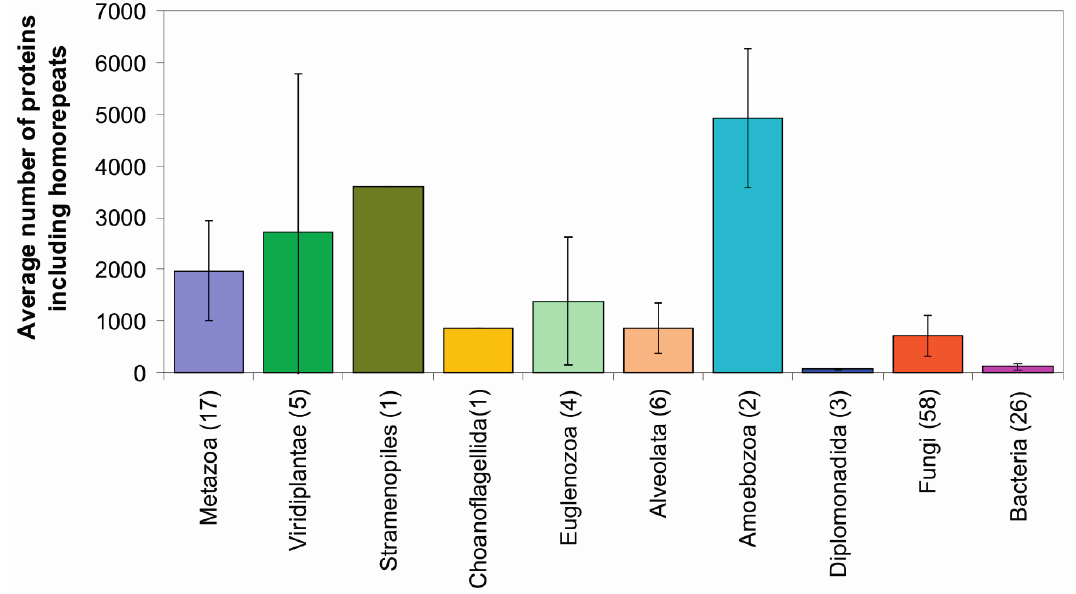
Figure 3. Occurrence of homo-repeats of 6 residues long for 20 amino acids in 122 proteomes. Numbers of proteomes are indicated in the parentheses. Error bars are standard